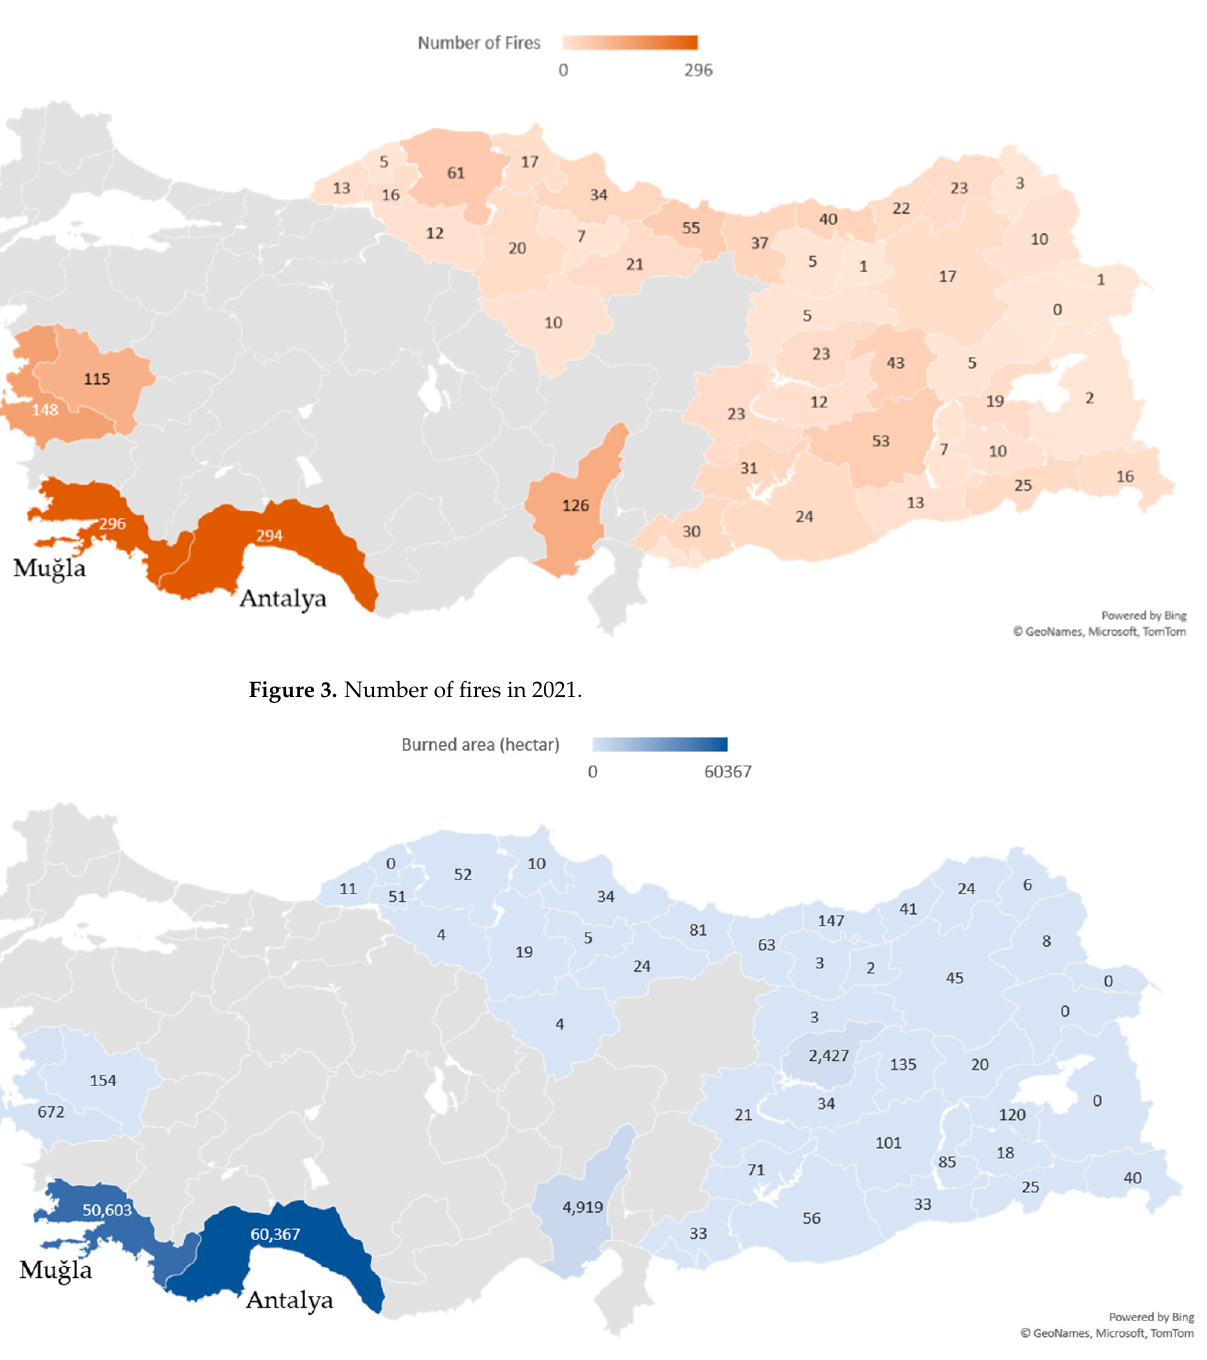
Figure 4. Burned area in 2021 (hectare).